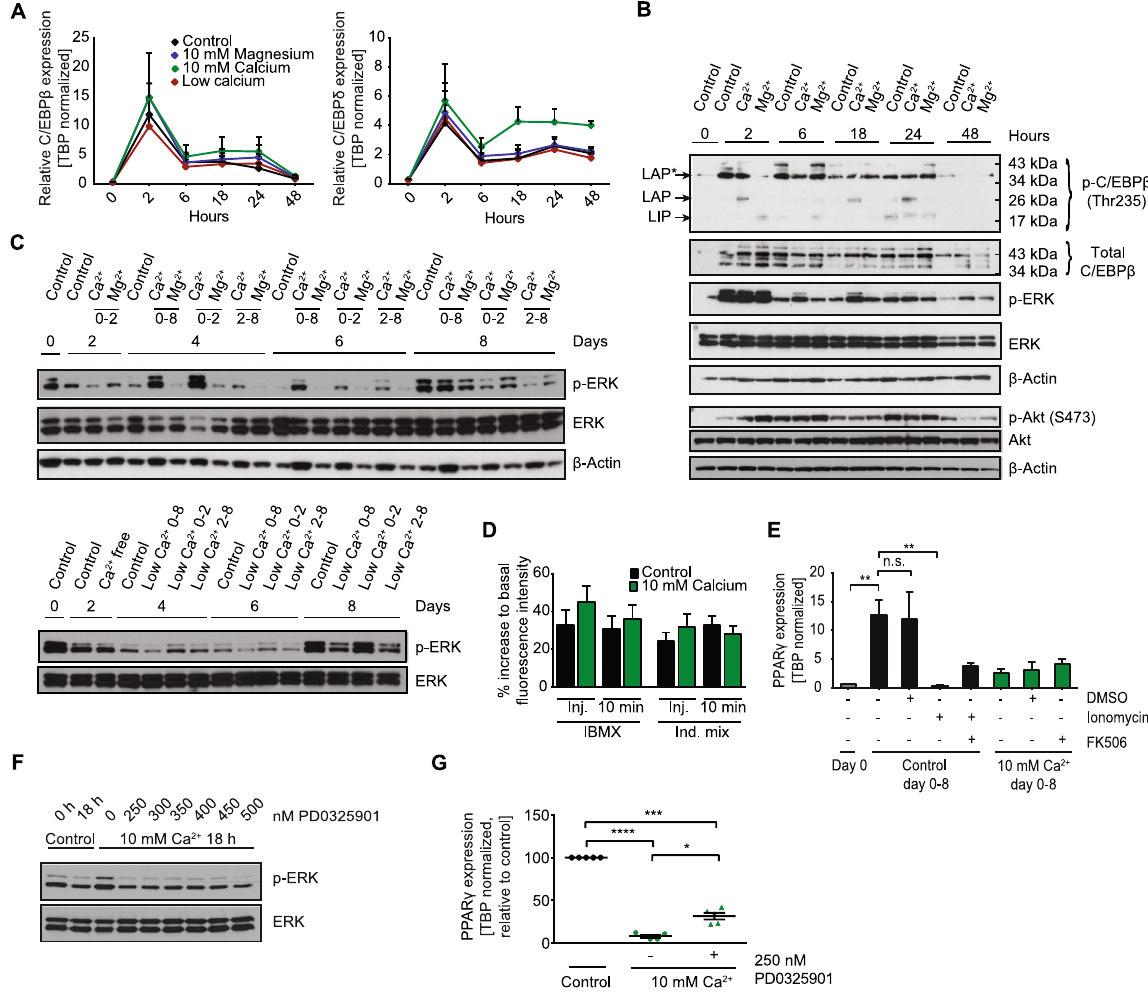
Figure 2. Extracellular calcium regulates MAPKs and C/EBP β activity independently of intracellular calcium. ( A ) C/EBP δ and C/EBP β expression normalized to TBP during the first 48 hours of differentiation in 1.8 mM calcium (control), 10 mM magnesium, 10 mM calcium and calcium free medium (n = 6). ( B ) Western Blot for phospho- (Thr235)/total C/EBP β as well as phospho-/total ERK and phospho- (Ser473)/total AKT during the first 48 hours of differentiation under 1.8 mM calcium (control), 10 mM magnesium (Mg 2 + ) and 10 mM calcium (Ca 2 + ) conditions with β -Actin as loading control. ( C ) Western Blot for phospho- and total ERK and β -Actin as loading control of the 8 day time course under control (1.8 mM calcium), 10 mM calcium and 10 mM magnesium conditions as well as control and calcium free conditions for the indicated duration. ( D ) Relative increase of intracellular calcium in brown preadipocytes maintained in 1.8 mM calcium (control) or 10 mM calcium directly upon and 10 min after injection of IBMX or induction mix shown as percent increase of fluorescence to basal level. Cells were loaded with the calcium binding fluorophore Fluo-4 (4 µ M) and fluorescence was recorded at Ex/Em = 485/520 in orbital averaging (n = 3 with 3–4 replicates each). ( E ) PPAR γ expression normalized on TBP in preadipocytes (day 0) and differentiated cells at day 8 treated day 0–8 with 1.8 mM calcium (Control day 0–8) or 10 mM calcium (10 mM Ca 2 + day 0–8) supplemented with DMSO, ionomycin (2 µ M) and/or the calcineurin inhibitor FK506 (1 µ M) (n = 3). ( F ) Western Blot for phospho-/ total ERK in preadipocytes (0 h) and induced preadipocytes (18 h) with different concentrations of the MEK inhibitor PD0325901. ( G ) PPAR γ expression as percent of control in differentiated adipocytes treated with 1.8 mM calcium (control) or 10 mM calcium + / − the MEK inhibitor PD0325901 (250 nM) for 0–8 days (n = 5). For ( A,D,E and G ) data are shown as mean ± SEM, * p < 0.05, ** p < 0.01, *** p < 0.001, **** p < 0.0001; ( A ) Ordinary two-way ANOVA with Dunnett’s posthoc test, ( D , G ) Repeated measures one-way ANOVA with Tukey’s posthoc test and Kruskal-Wallis one-way ANOVA with Dunn’s multiple comparison test ( E ). Full Western Blot images are provided in the Supplemental